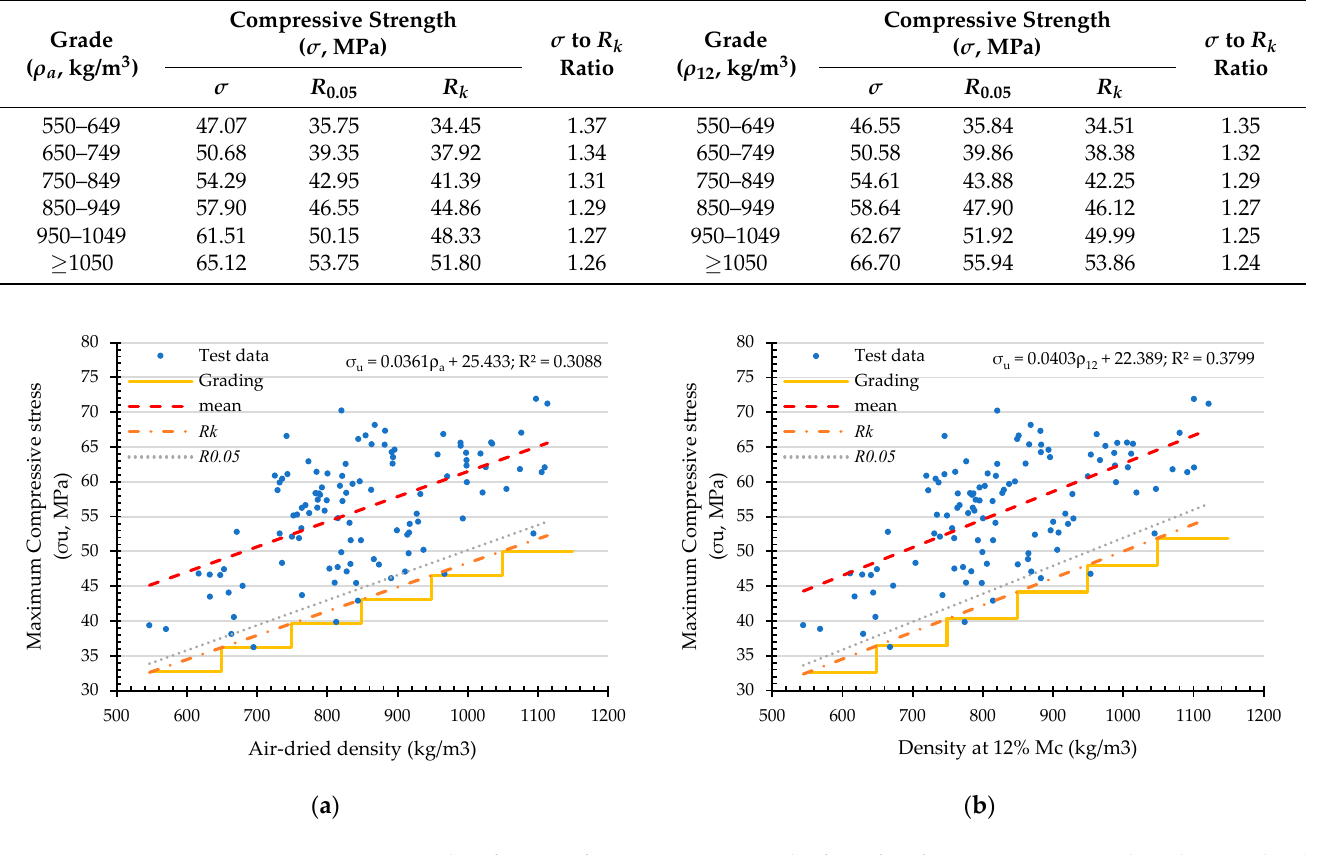
Figure 16. Classification of compressive strength of Dendrocalamus sericeus Munro based on air-dried density ( a ) and at 12% M C ( b ). Table 7. Compressive load grade classification of Dendrocalamus sericeus Munro based on air-dried linear mass and at 12% M C